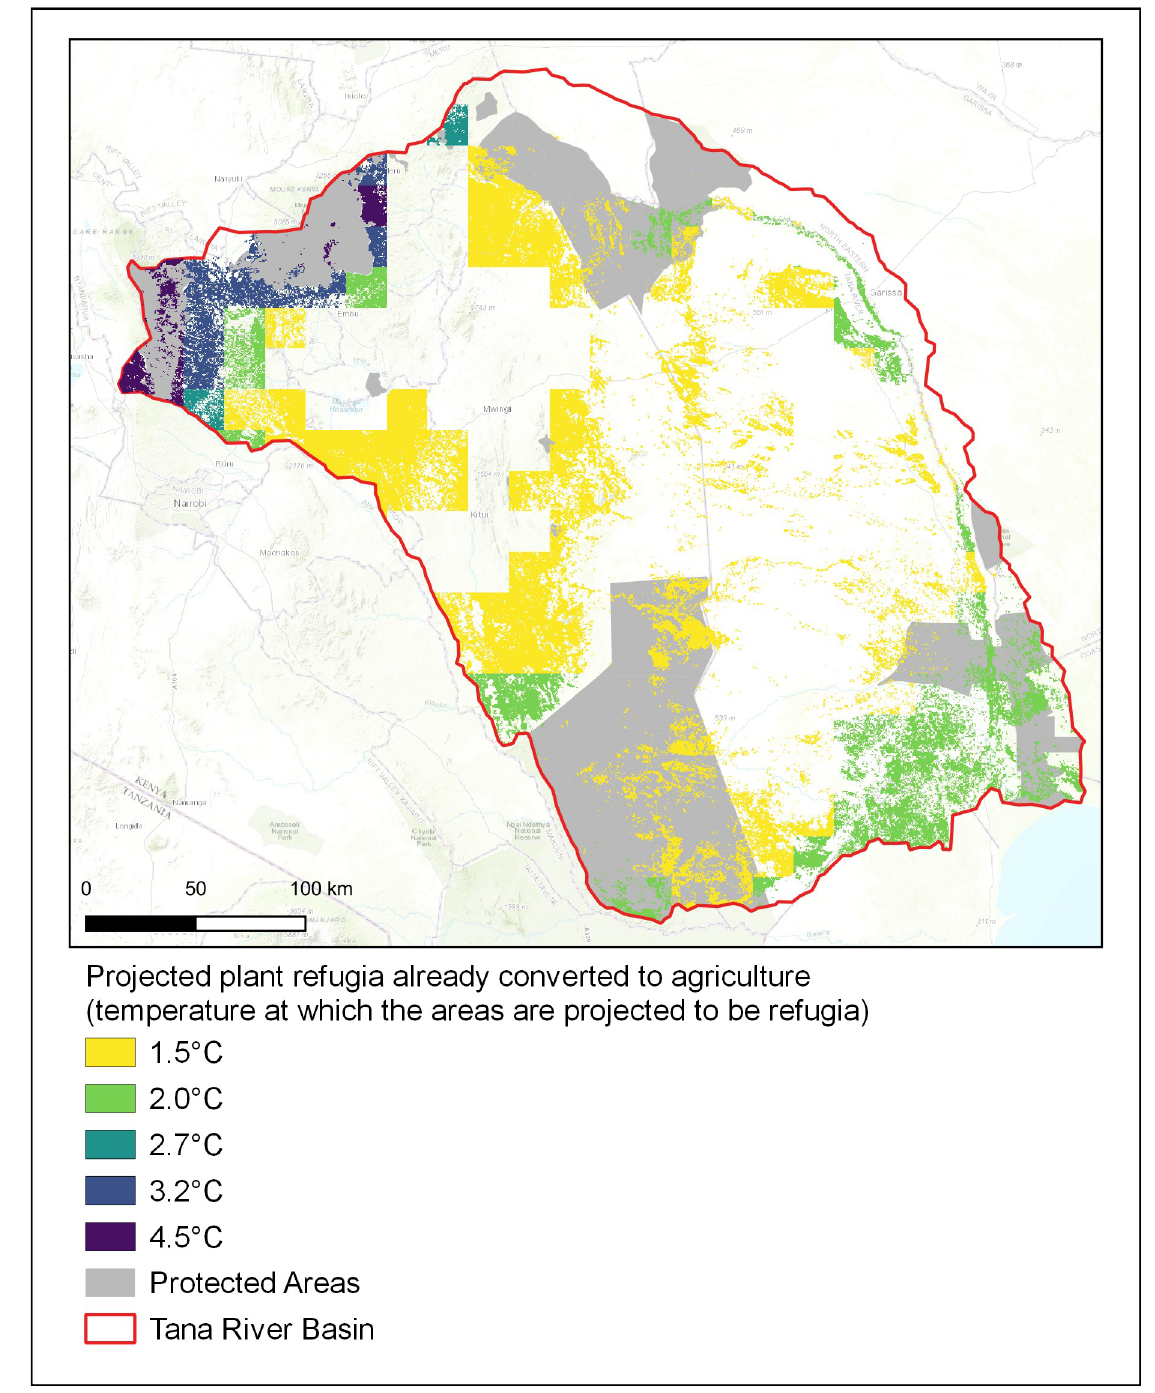
Fig 5. Agricultural land that was projected to be refugia for plants under different levels of warming. These are areas that are projected to contain refugia for plants which have already been converted to agricultural land uses. Projected refugia are identified using the criterion that 11 or more GCMs agree on their